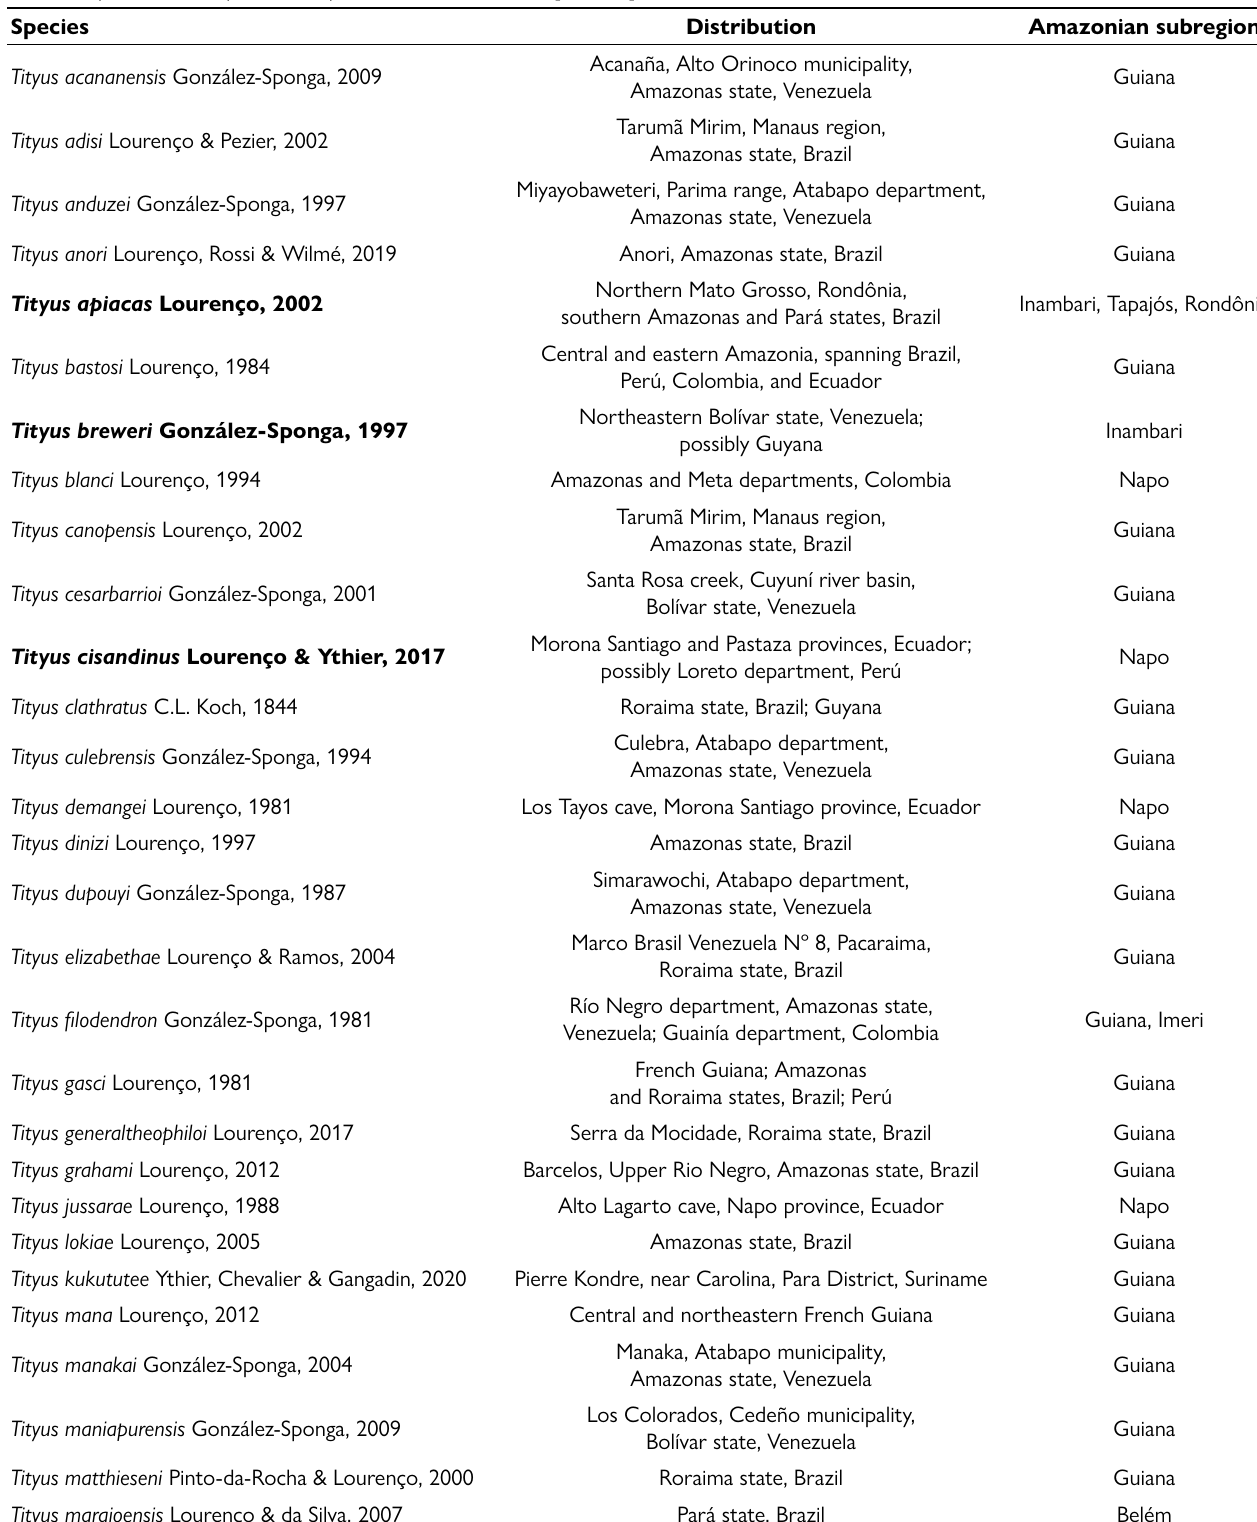
Table 1. Updated list (as of January 2021) of Amazonian species (n = 49) in the genus Tityus and their distribution in Amazonian areas of endemism [17]. Species from Brazilian Amazonia are listed based on Monteiro et al. [5], with updates from Lourenço et al. [20]. Species from French Guiana are listed based on Ythier [26], species from Venezuela are based on Ochoa and Rojas-Runjaic [27] and González-Sponga [28], and records from Colombia according to Lourenço [29]. Species in bold correspond to taxa implicated in reported envenomation cases [5, 15,